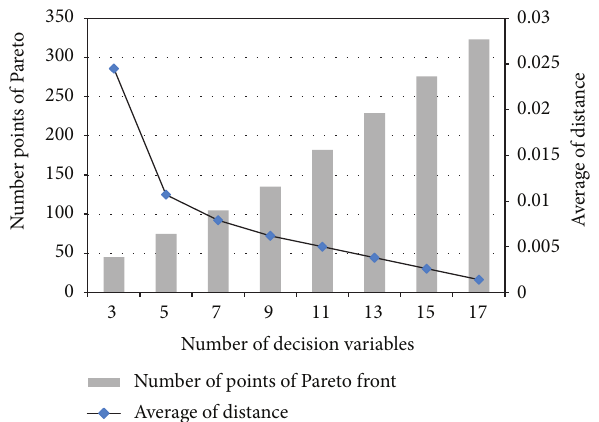
Figure 8: Evaluation of the Pareto front in terms of (1) the number of points of Pareto front and (2) the average of distance, where the right-side 𝑦 -axis is the average distance of the Pareto front, the left- side 𝑦 -axis is the number of points of the Pareto front, and the 𝑥 -axis isthenumberofdecisionvariables,whichisthenumberofprices(or